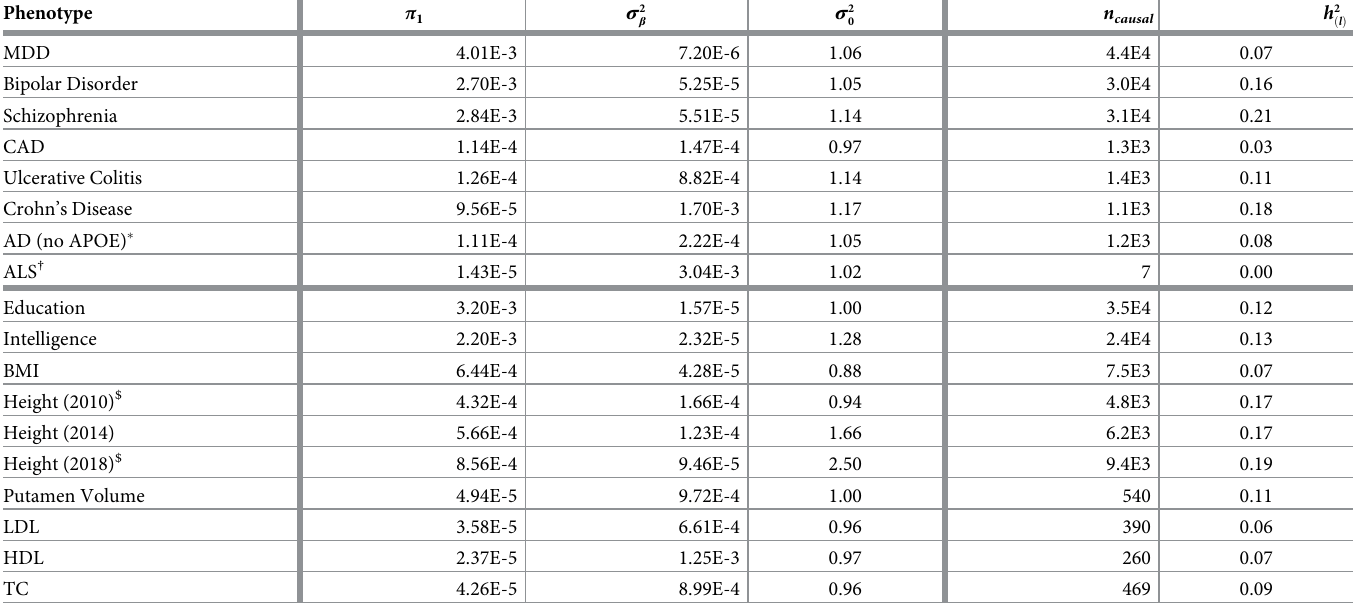
Table 2. Summary of model results for phenotypes shown in Figs 1 and 2. The subscript in h 2 SNP heritability is on the liability scale. MDD: Major Depressive Disorder; CAD: coronary artery disease; AD: Alzheimer’s Disease (excluding APOE locus; � for the full autosomal reference panel, i.e., including APOE, h